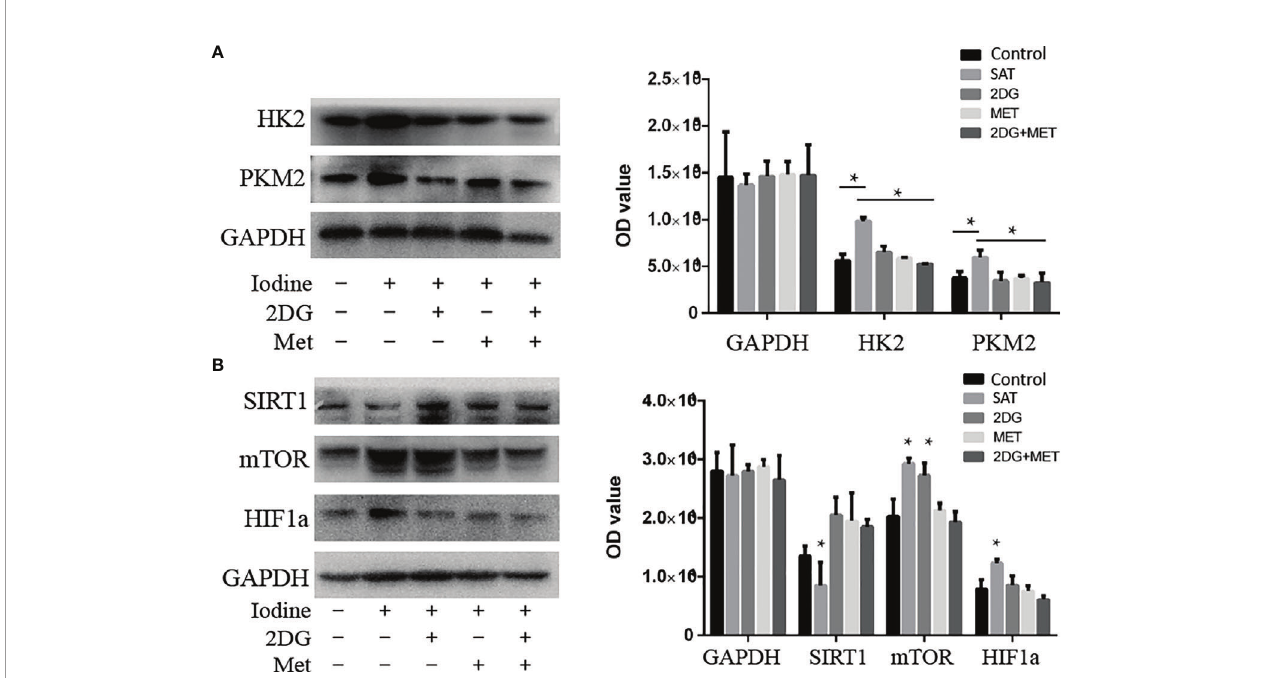
FIGURE 4 | Treatment with 2DG and/or metformin deactivated the mTOR/HIF-1 a /HK2/PKM2 pathway in CD4+ T cells of SAT mice. CD4+ T cells were extracted from SAT mice treated with 2DG, metformin, or combination, and expression of glycolysis-related enzymes were evaluated by western blot (n = 7 per group). (A) The expression of key glycolysis-related enzymes (HK2 and PKM2) of cultured SAT CD4+ T cells were measured by western blot. (B) The expression of key pathway related proteins (sirt1, mTOR, and HIF-1 a ) were measured by western